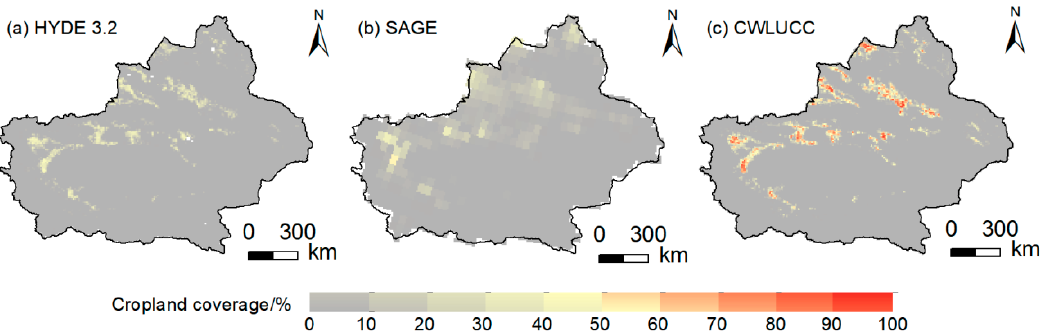
Figure 5. Cropland spatial pattern in Xinjiang province for AD 2000 from HYDE 3.2, SAGE, and CWLUCC.